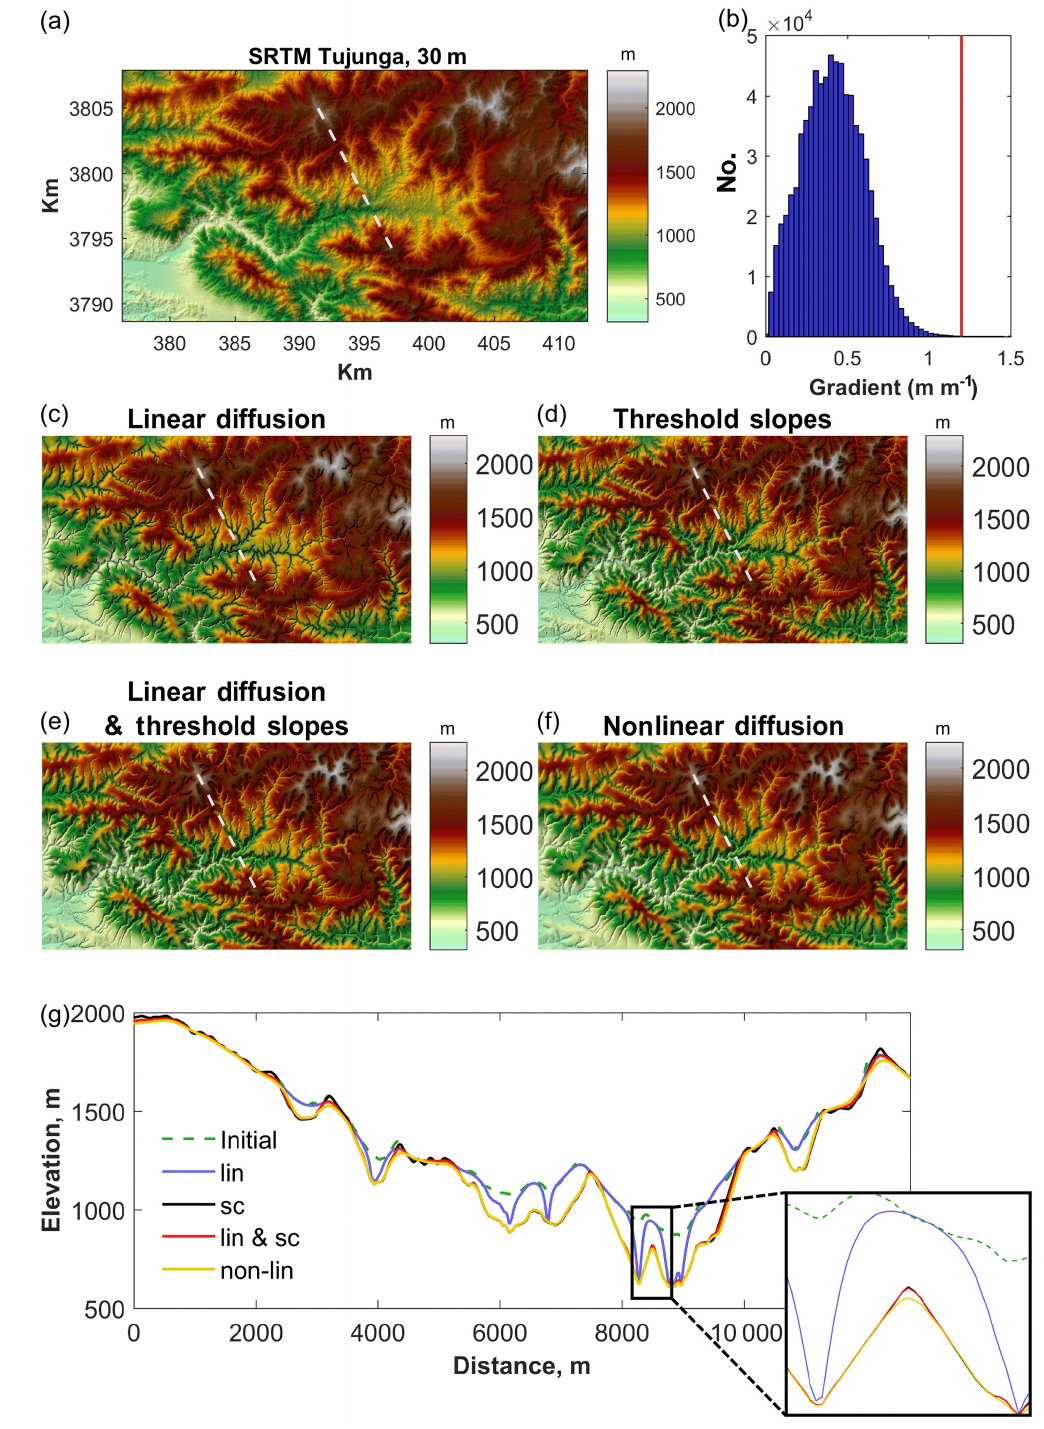
Figure A2. Hillslope response to river incision. (a) Standard SRTM DEM (30m) included in TopoToolbox representing the Big Tujunga region. The dotted gray line indicates the location of the transect shown in panel (g) . (b) Resulting topography after 500000years using four different descriptions for hillslope evolution. (c) Linear diffusion over all slope values (lin in panel g ). (d) Threshold landscape where no slopes exceed the threshold slope (sc in panel g ). (e) Linear diffusion combined with immediate adjustment to a threshold slope (lin and sc in panel g ). (f) Nonlinear diffusion combined with immediate adjustment to a threshold slope (non-lin in panel g ). (g) Elevation profiles of the different model runs compared with the initial profile. Model parameter values are listed in Table